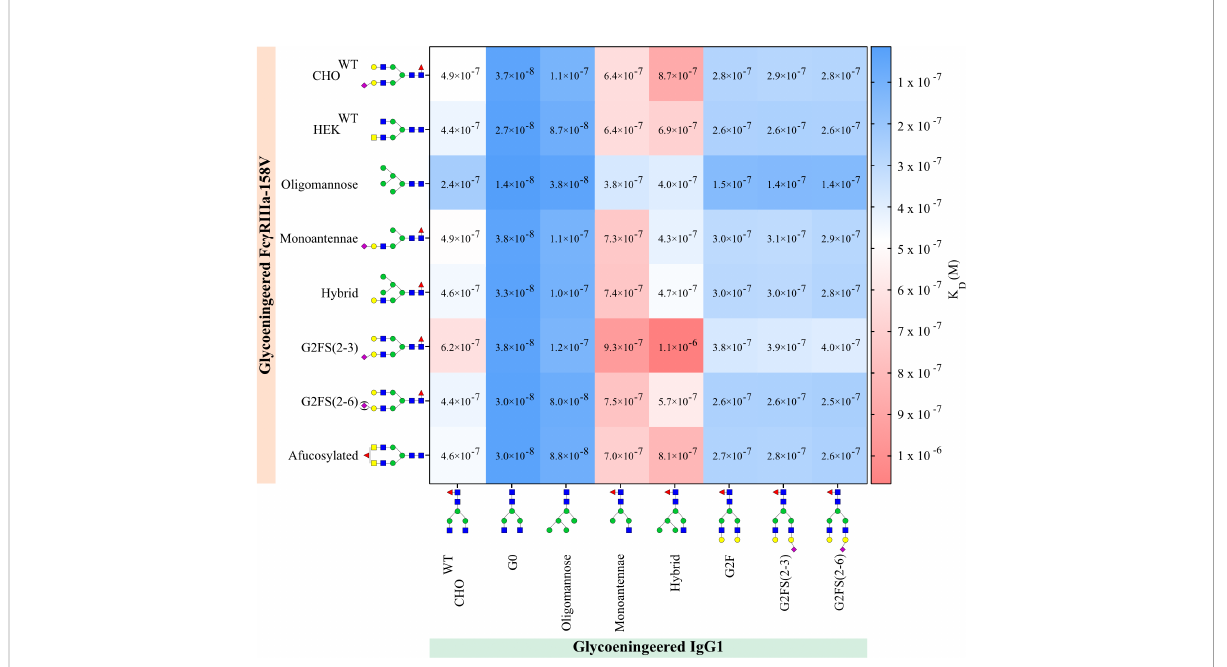
FIGURE 4 IgG1 and Fc g RIIIa-158V binding. Surface plasmon resonance dissociation constant (K D ) was determined from SPR analysis after biotinylated glycoengineered Fc g RIIIa-158V was spotted at 4 concentrations and bound to glycoengineered IgG1 at 8 times dilution series. Calculation of the dissociation constant was performed by equilibrium fi tting to R max = 500. Mean data is reported of three independent experiments for each IgG1:Fc g RIIIa-158V